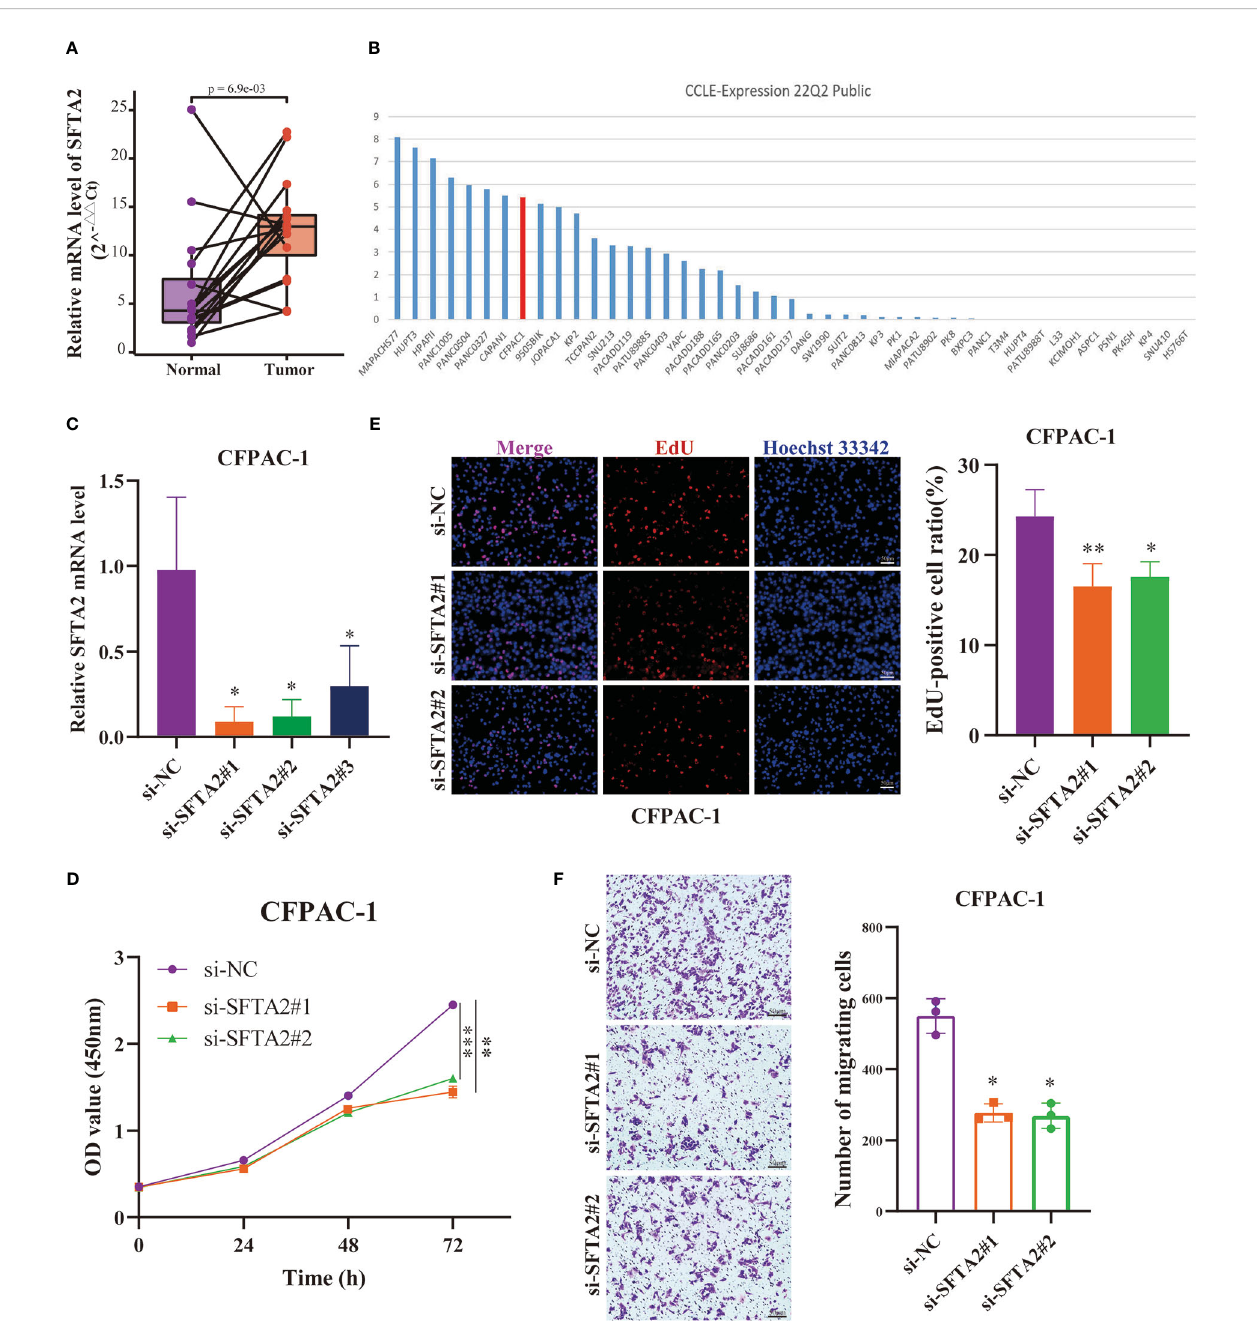
FIGURE 11 Expression and function of the highest-risk SFTA2 gene in PMSRPS. (A) qRT-PCR analysis of SFTA2 mRNA levels in randomly selected 16 pairs of PAAD tissues and corresponding adjacent tissues. (B) The Cancer Cell Lines Encyclopedia (CCLE) database was searched for PAAD CFPAC-1 cell lines suitable for SFTA2 intervention. (C) Validation of knockdown ef fi ciency of SFTA2 interfering fragments in CFPAC-1 cells by qRT-PCR. (D) CCK-8 assay was used to assess the effect of SFTA2 silencing on CFPAC-1 cell viability. (E) EdU staining was used to assess the effect of SFTA2 silencing on the proliferative capacity of CFPAC-1 cells. (F) Transwell experiments were used to evaluate the effect of SFTA2 silencing on the migration ability of CFPAC-1 cells. * P < 0.05, ** P < 0.01, *** P <